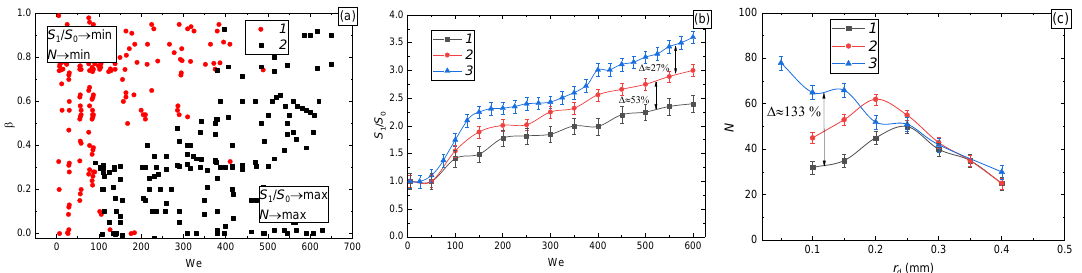
Figure 4. ( a ) Regime map of the drop impact accounting for the angular parameter and Weber number: 1 — deposition of the first drop and coalescence with all others; 2 — breakup; ( b ) S 1 / S 0 (We); ( c ) size distribution of child droplets at We=200 and at different impingement angles: 1 — α d = 0 – 30°; 2 — α d = 30 – 60°; 3 — α d = 60 – 90°.